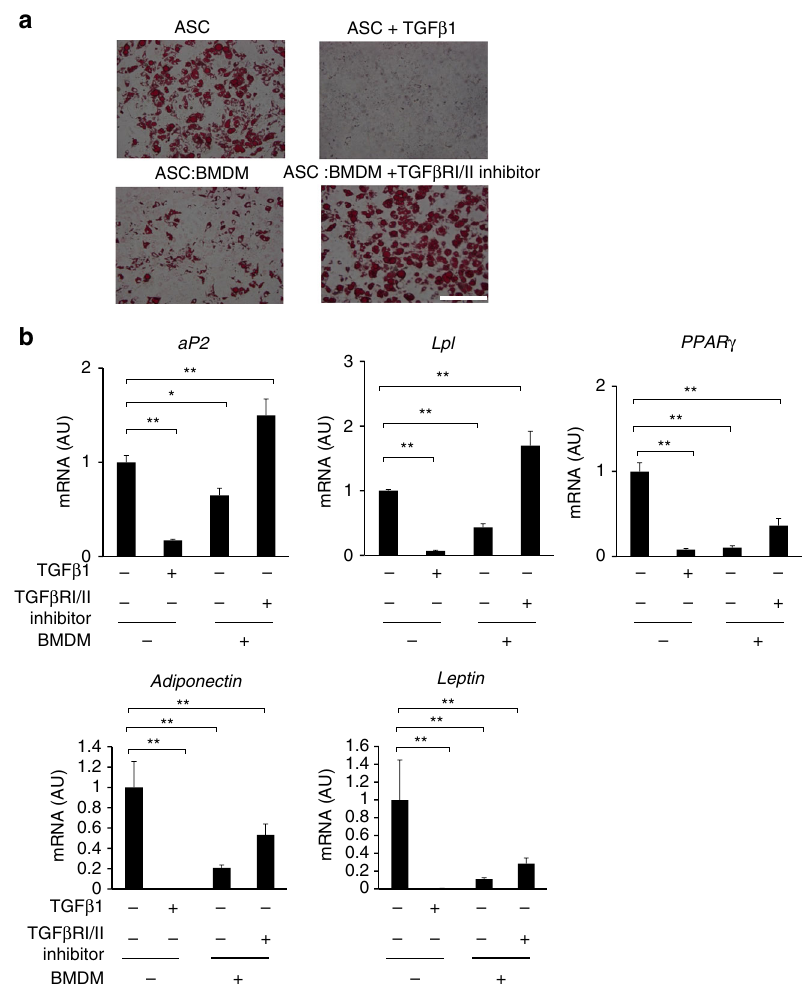
Fig. 5 In vitro coculture of BMDM and ASC. a Oil red O staining of ASC and ASC:BMDM co-culture after adipogenesis stimulation for 12 days. Addition of TGF β 1 ( right upper panel ) and BMDM to ASC ( left lower panel ) inhibited adipogenesis. BMDM inhibitory effect on ASC adipogenesis was released by addition of TGF β RI/II inhibitor. Scale bar , 200 μ m. b The relative expression levels of late adipogenesis markers. The data were calculated from experiments of 3 – 6 dishes per group. The data are shown as the means ± SEM. * P < 0.05, ** P < 0.01 compared with control by